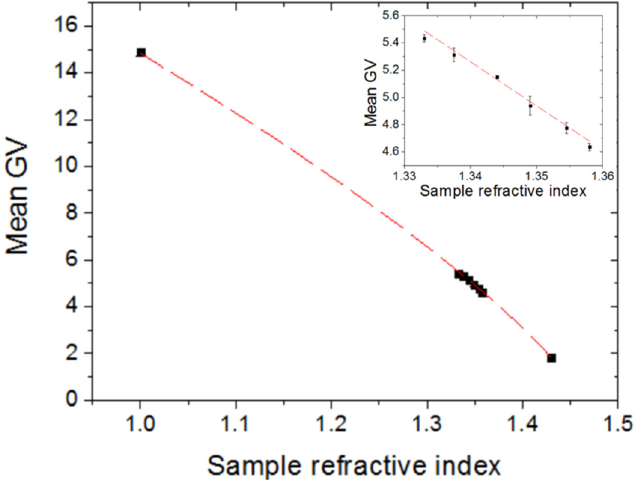
Figure 5. Mean gray value (GV) as a function of the sample refractive index in the interval [1, 1.43]. Inset shows the mean GV in the RI range [1.333, 1.358]. Dashed red lines represent data fits.